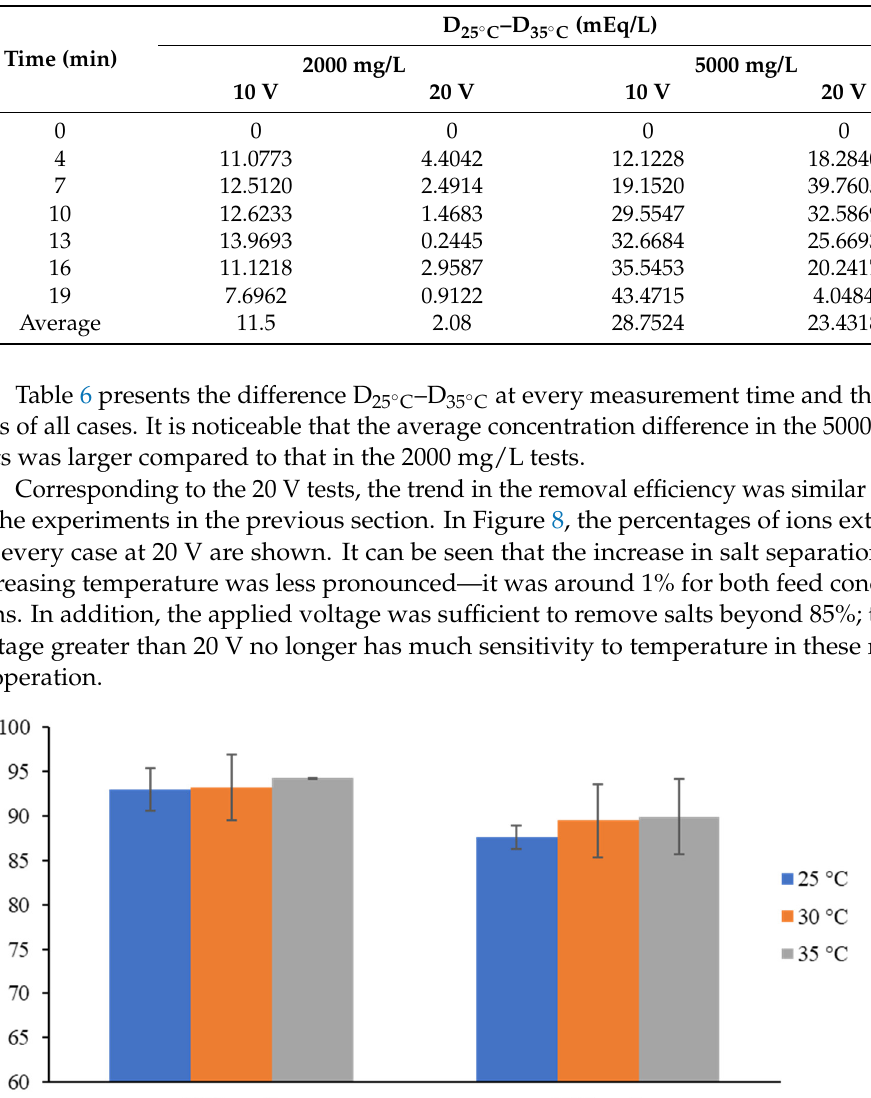
Figure 9. Diluate stream concentration over time at 20 V. 3.5. Comparison with NOM-127 Standards Another important point of comparison is the salinity of the diluate water with re- spect to the Official Mexican Standard (NOM-127-SSA1-1994). Ref [31] indicates 1000 mg/L TDS as a permissible limit for water for human consumption. Figures 10 and 11 show how TDS was eliminated over time for the samples at the three inlet temperatures and the two voltages.